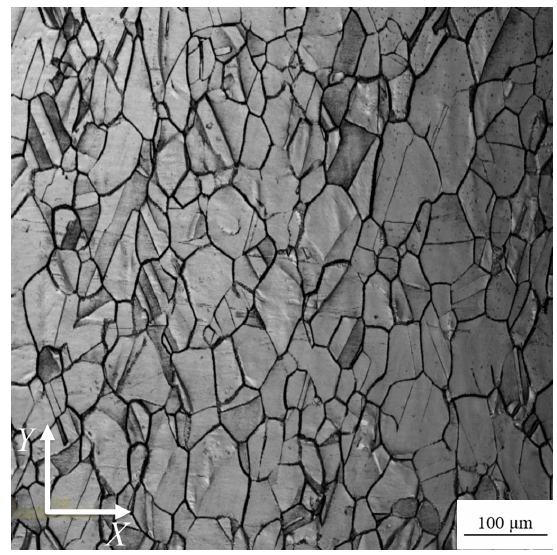
Figure 1. Metallurgical photograph of CuNi 2 Si alloy.